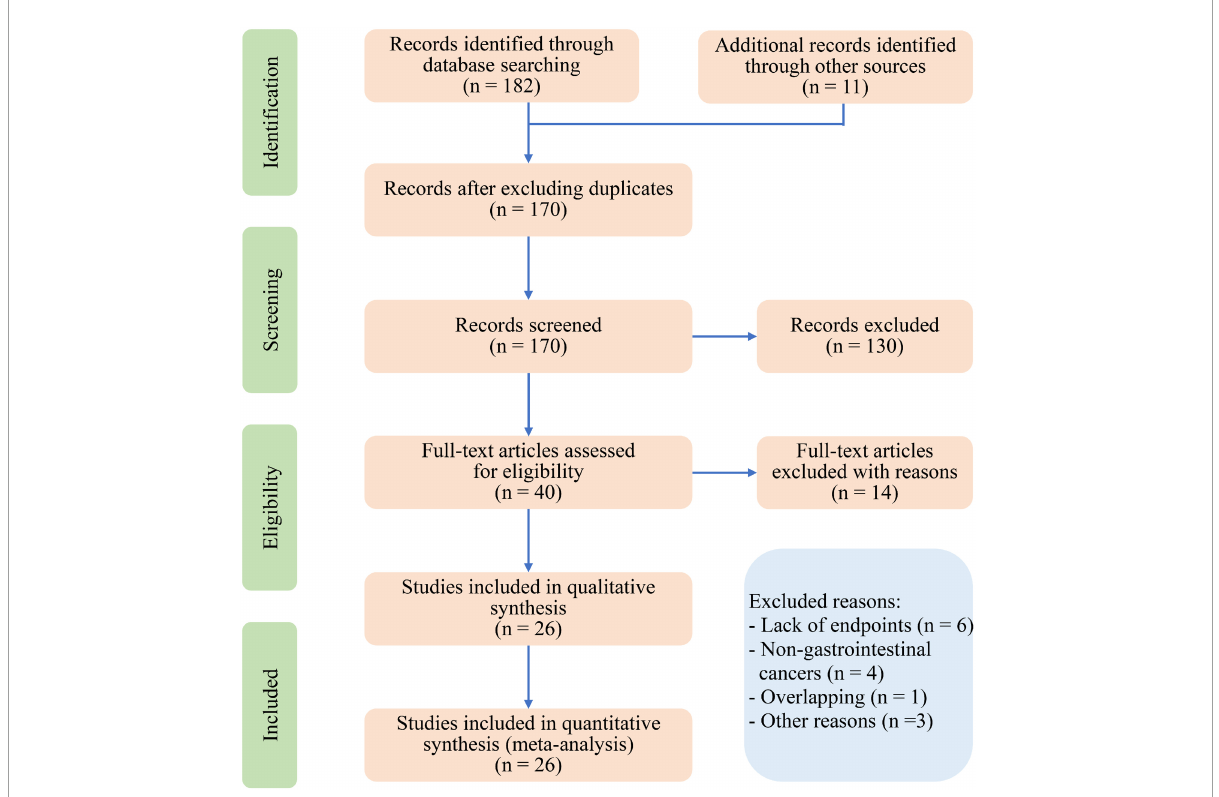
FIGURE1 Preferred reporting items for systematic review and meta-analysis (PRISMA) flow diagram for study